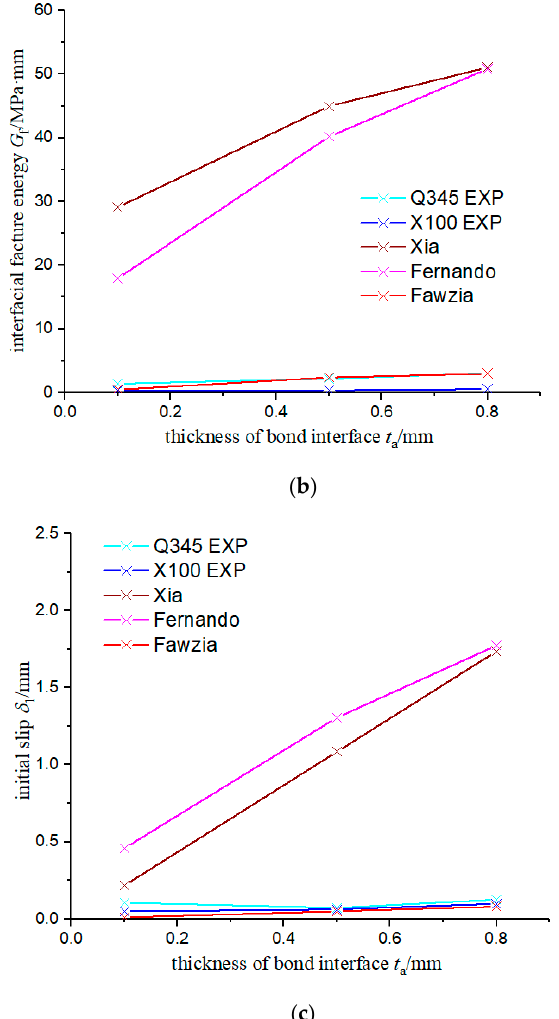
Figure 5. Comparison of Calculation Results of Three Bond–Slip Models and the Experimental Result. ( a ) Maximum shear stress. ( b ) Interfacial facture energy. ( c ) Initial slip.